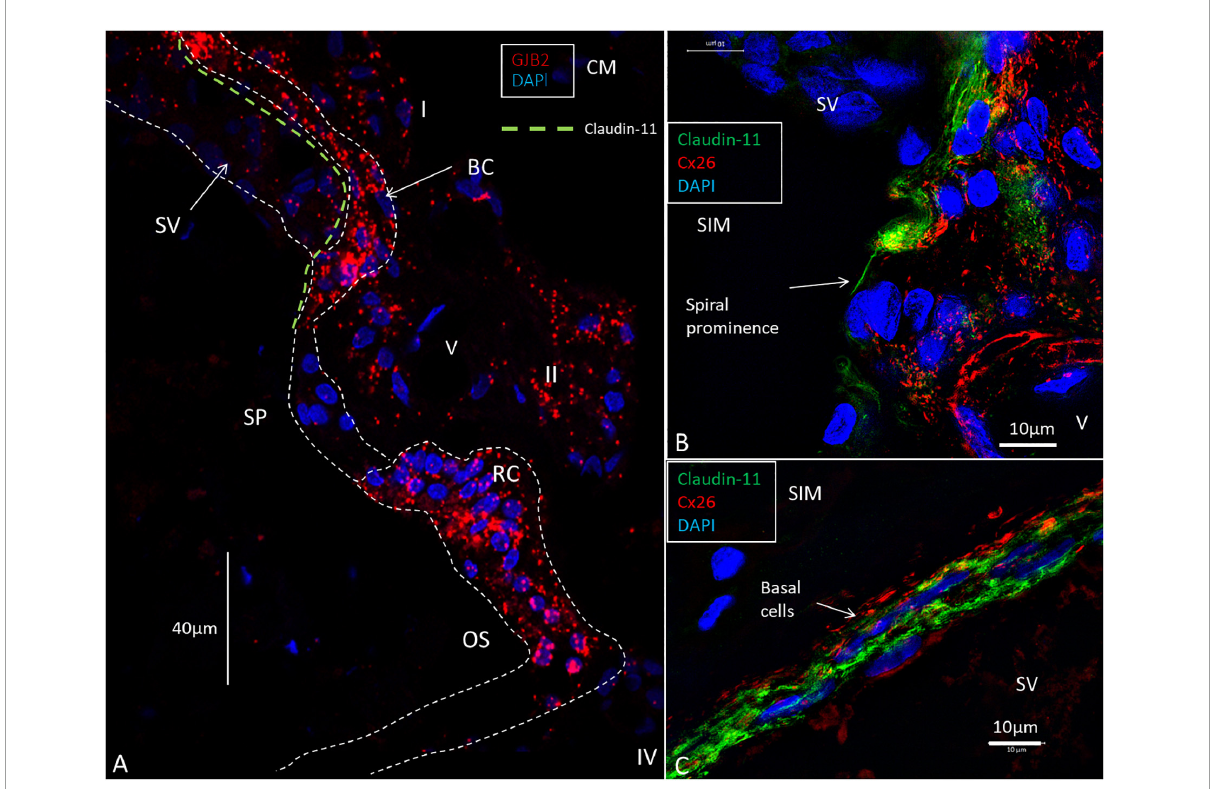
FIGURE10 RNAscope of GJB2 transcripts in the spiral prominence and outer sulcus. (A) The outer sulcus (OS), root cells (RC), and basal cells (BC) are rich in GJB2 gene transcripts, while the spiral prominence epithelium virtually lacks gene puncta. The type I and II fibrocytes contain moderate numbers of gene transcripts. The green broken line shows the location of the Claudin-11 TJ barrier. (B) SR-SIM of Cx26 and Claudin-11 expression at the transitional zone between the stria vascularis (SV) and spiral prominence. A layer of the tight junction protein can extend to the spiral prominence (arrow). (C) SR-SIM of Cx26 and Claudin-11 protein expression in the basal cells of the SV. V: vessel. I: type I fibrocytes. II: type II fibrocytes. CM: Confocal microscopy. SIM: structured illumination